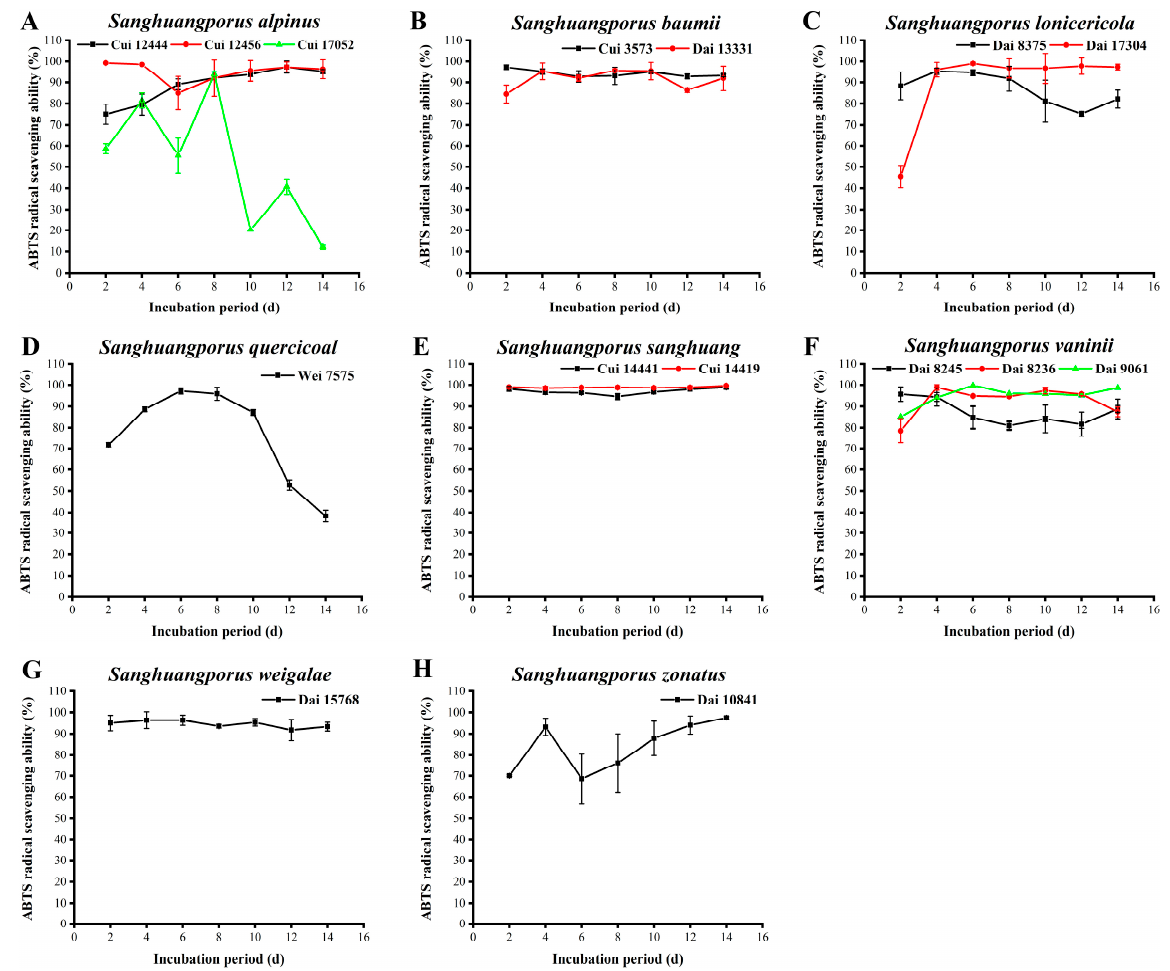
Figure 10. Variations in ABTS radical scavenging activities during submerged fermentation of 15